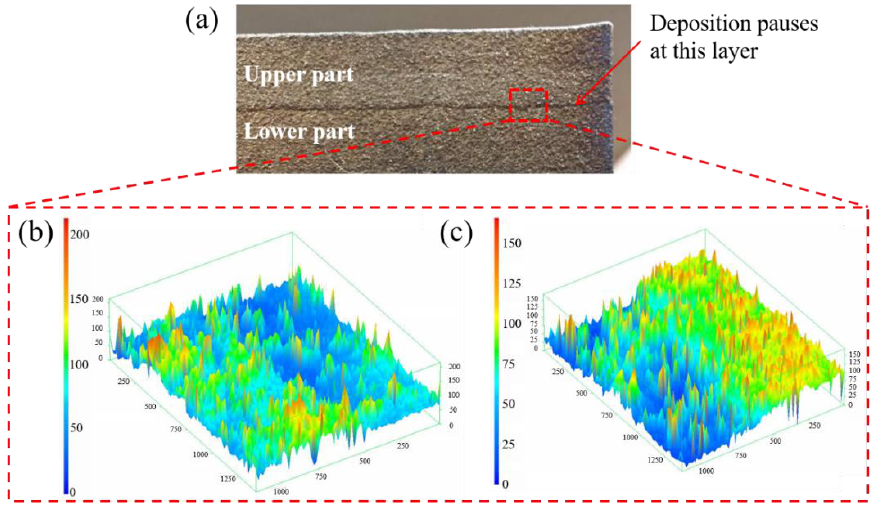
Figure 8. Morphology of the deposited thin wall through deposition-pause-deposition: ( a ) deposited thin wall, ( b ) front surface scanning by laser confocal microscope and ( c ) reverse surface scanning by laser confocal microscope.